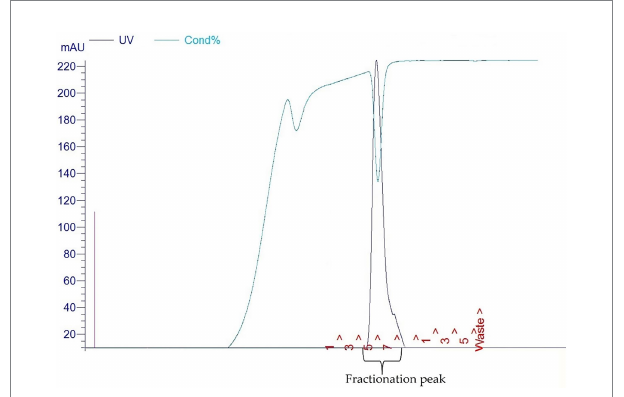
FIGURE 2 Fast protein liquid chromatography chromatograms (FPLC) of E34 TSP.